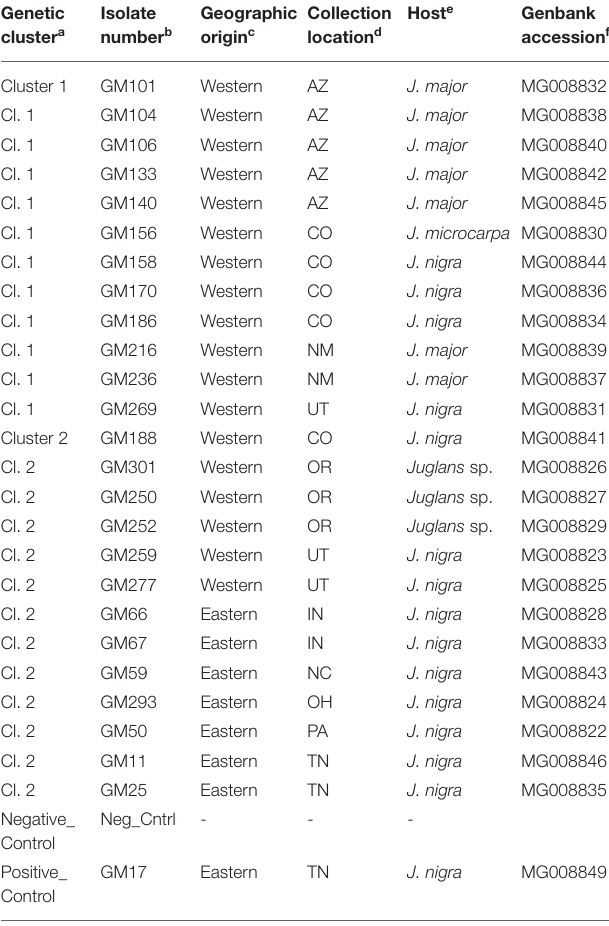
TABLE 1 | Geosmithia morbida isolates selected for inoculation experiment per genetic groupings of Hadziabdic et al. unpublished. Genetic cluster